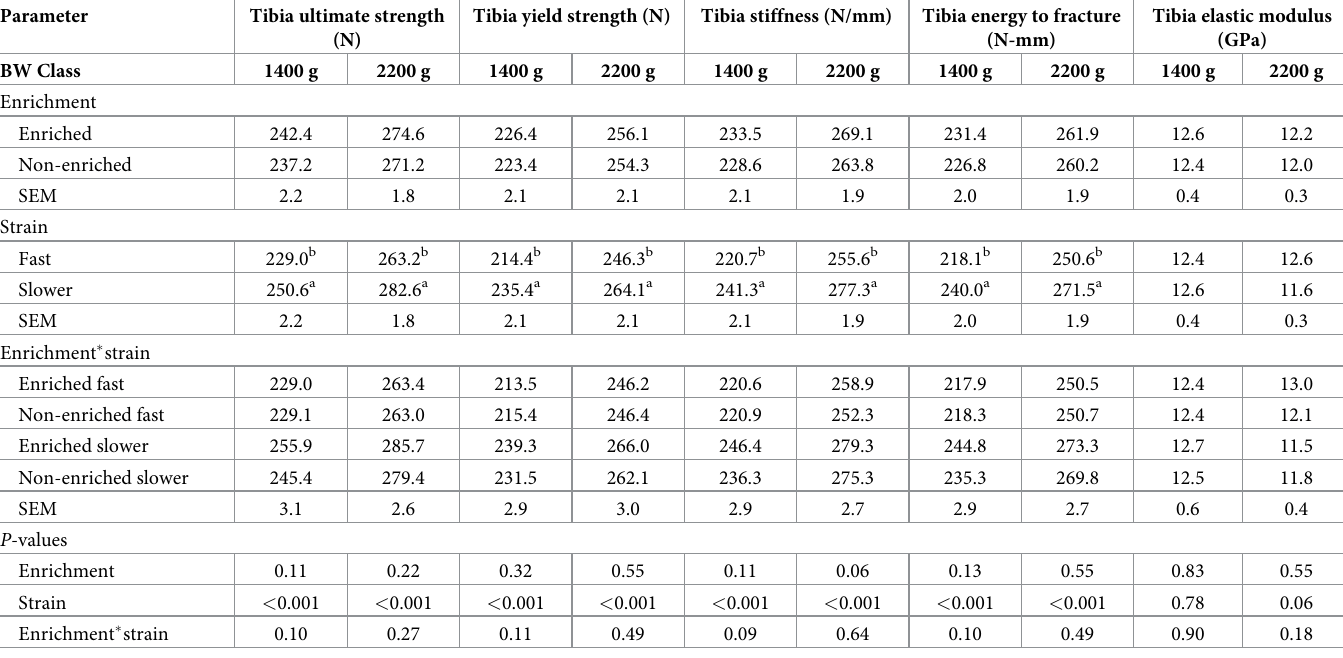
Table 5. Effects of pen enrichment (enriched or non-enriched), broiler breeder strain (fast-growing ross 308 or slower-growing Hubbard JA 757) and their interac- tion on tibia mechanical characteristics of male broiler offspring in two body weight classes (1400 and 2200 g) (2 chickens per pen, n = 7 pens per treatment, LSmeans ±